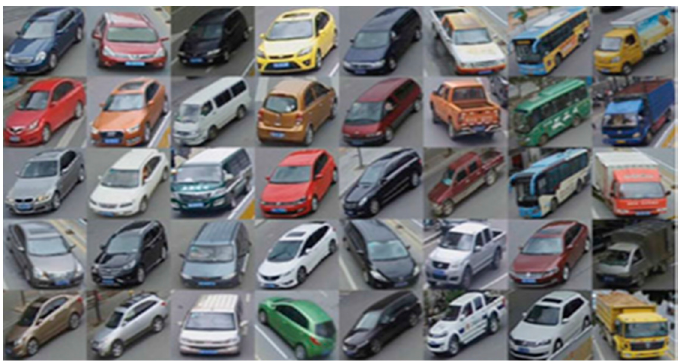
Figure 7. Depicts sample images of the VeRi ‐ 776 dataset.